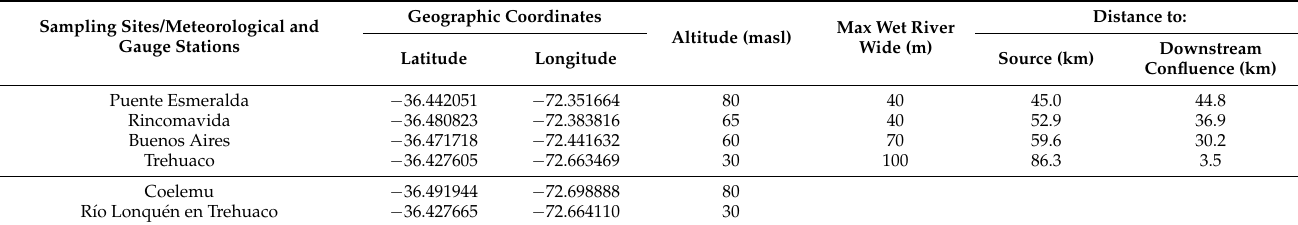
Table 1. Location of the sampling sites of the Lonqu é n River and distance to source and downstream confluence. Geographic Coordinates Distance to: Sampling Sites/Meteorological and Altitude (masl) Max Wet River Gauge Stations Wide (m) Latitude Longitude Source (km) Downstream Confluence (km) Puente